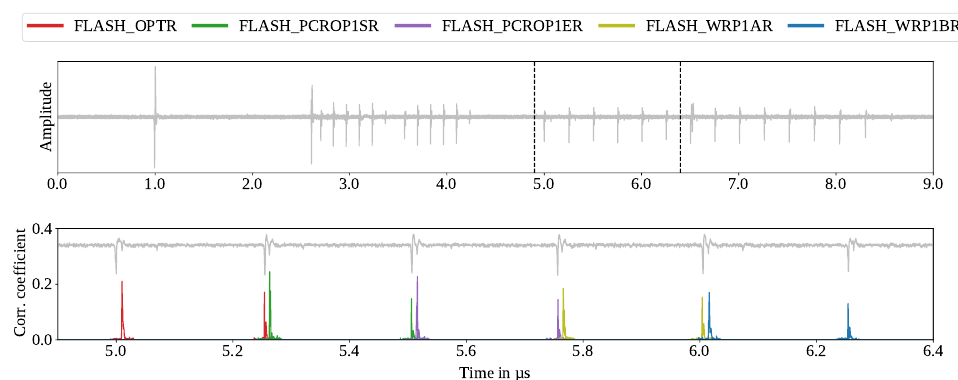
Figure 6: EM trace during the boot phase of an STM32L4 microcontroller (top). The zoom (bottom) of the region between the two dashed lines shows the results of a correlation-based leakage test on the option byte registers with 200 000